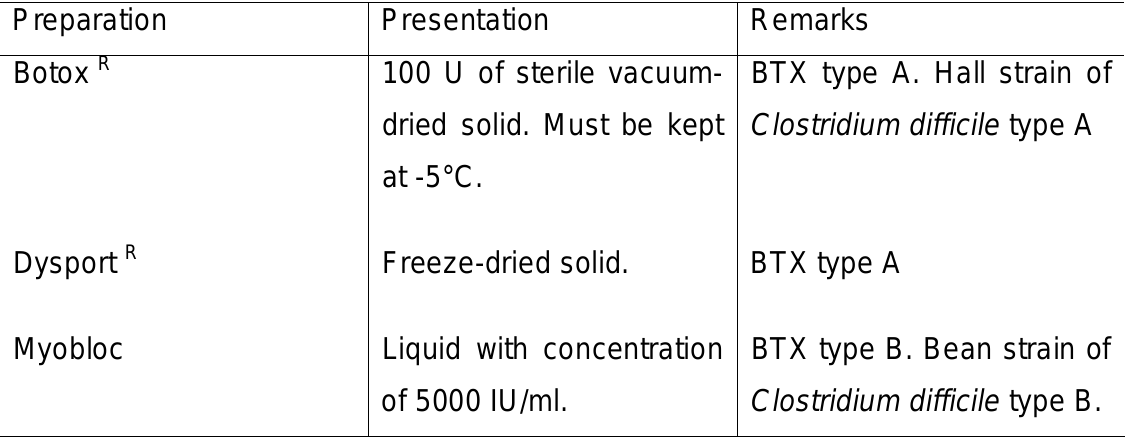
Table 4: Commercial preparations